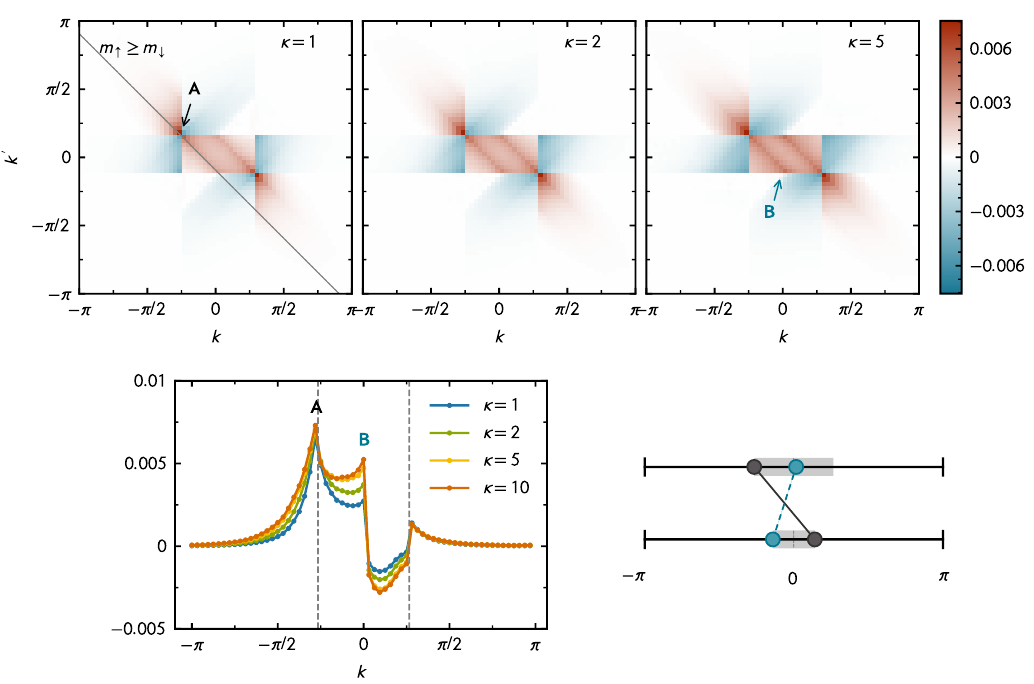
Figure 6: Pairing in heavy-majority systems. Top row panels : Shot-noise correlator G ↑↓ for ( N ↑ , N ↓ ) = ( 17,9 ) particles and mass imbalances κ = 1,2, and 5. Bottom left = − q , corresponding to the gray dashed line in panel : Cuts of G ↑↓ along constant k tot the upper left panel (the statistical error bars are smaller than the symbol size). The peaks labeled “A” and “B” correspond to the points marked in the upper panels. The vertical gray dashed lines indicate the position of the Fermi points associated with ↑ the majority species k = ± k . Bottom right panel : Sketch of the pairing mechanism F in momentum space. The upper (lower) line depicts the first Brillouin zone of the spin-up (spin-down) species. The end points of the gray-shaded bands correspond to the Fermi points of the two species. Finally, the big black dots connected with a black solid line symbolize standard BCS-type pairing “across the Fermi lines” (gray-shaded bands) which gives rise to peak A. The big blue dots connected with a dashed blue line symbolize the second most dominant pairing correlation which gives rise to the peak